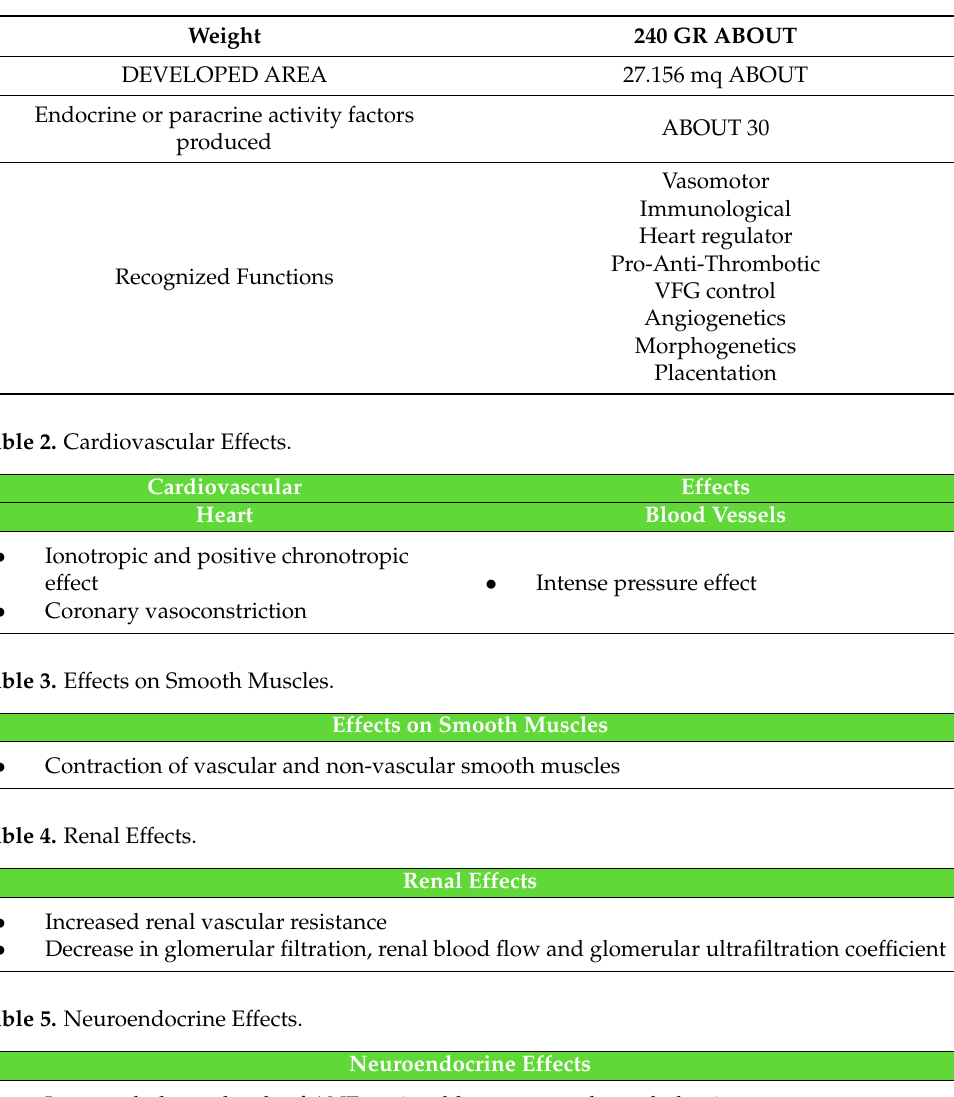
Table 1. Endocrine/paracrine activity factors.